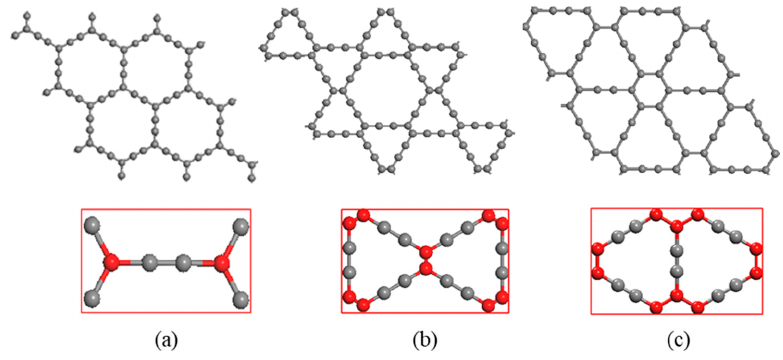
Figure 1. Three crystal structures of graphyne ( a ) α -graphyne ( b ) β -graphyne ( c ) γ -graphyne.